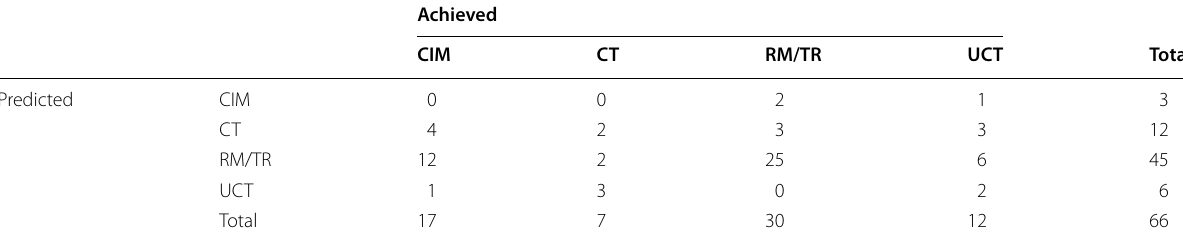
Movement classified as: clinically insignificant movement (CIM), controlled tipping (CT), root movement (RM)/translation (TR) and uncontrolled tipping (UCT). Each cell count represents the number of incisors classified for each movement type. All types of OTM predicted were included in the analysis as in all cases the ClinCheck ® reported greater than 5 degrees of root tip